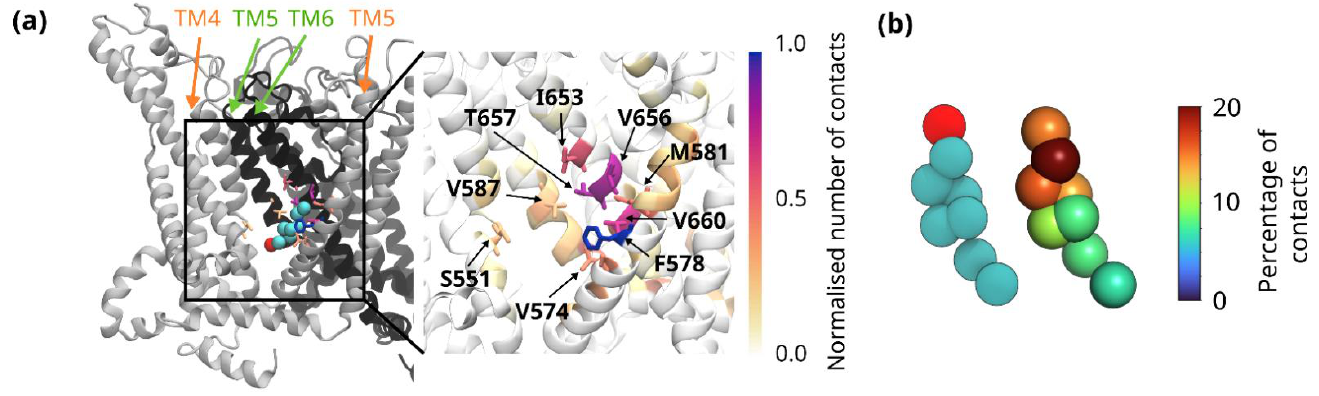
Figure 4. ( a ) TRPC3 shown in cartoon representation, where the residues in the stick representation are coloured according to the number of contacts made with cholesterol, once it has bound to Val-660. The left panel shows an example cholesterol molecule present at this site, taken from the final frame of a 10 μs simulation. The polar ROH group is coloured red. To highlight the subunit interface, one monomer is shown in black and the second monomer is shown in grey. In the zoom-in panel on the right, both monomers are shown in white. ( b ) The distribution of contacts between Thr-657 and bound cholesterol molecules. On the left is the coarse-grained representation of cholesterol, with the polar ROH group highlighted in red. The right shows the cholesterol beads coloured by the percentage of contacts they account for.